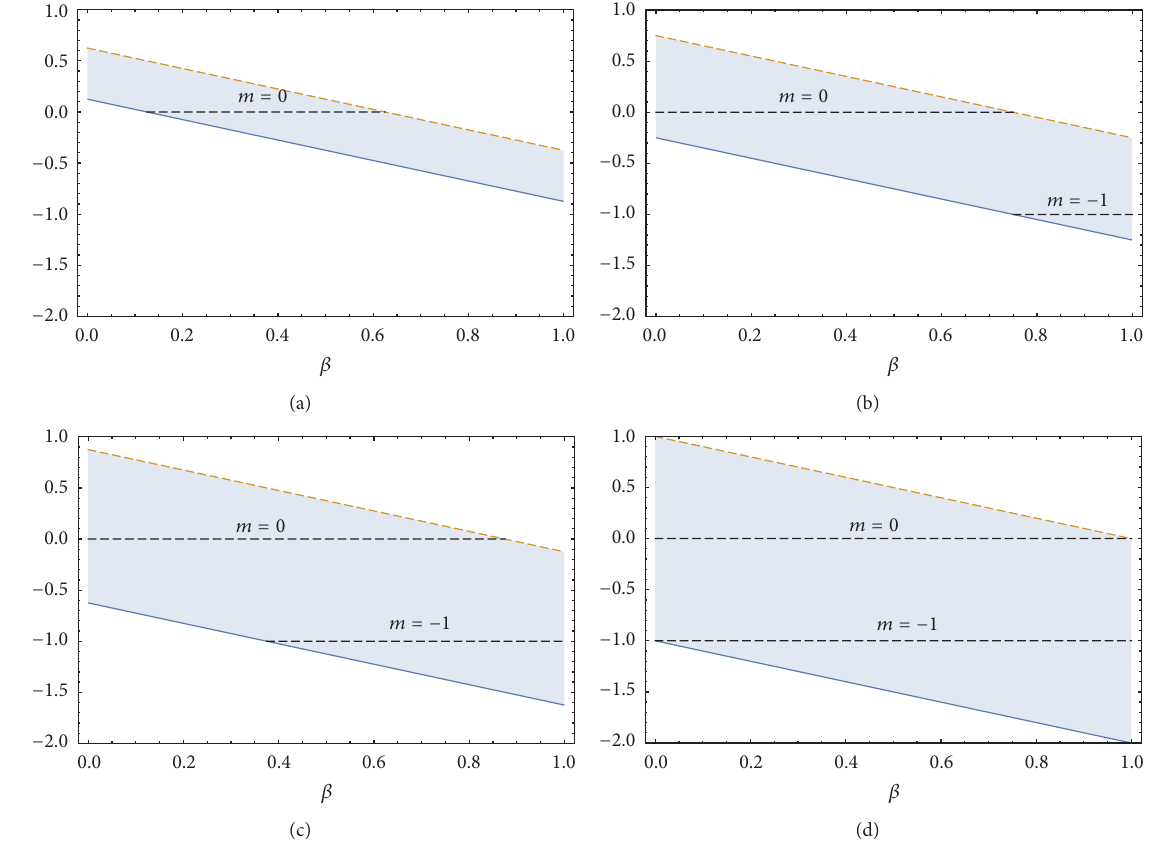
Figure 2: Cross sections of Figure 1 for different values of the deficit angle: (a) 𝛼 = 0.25 , (b) 𝛼 = 0.50 , (c) 𝛼 = 0.75 , and (d) 𝛼 = 1.00 . The shaded area schematically represents that area in which the operator ℎ 0 is not self-adjoint. The dashed lines represent the values of angular moment quantum